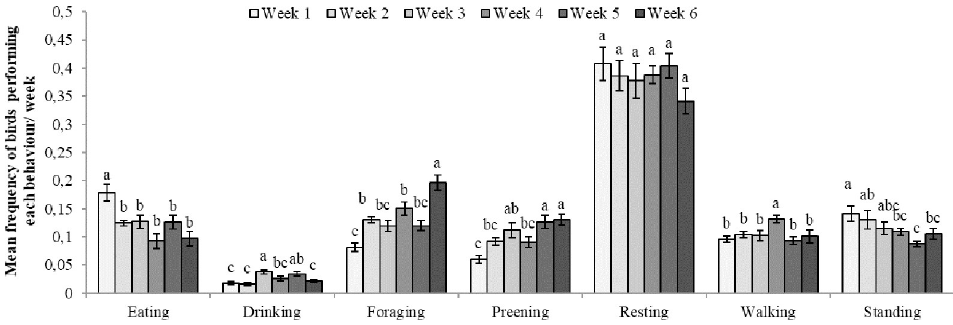
Fig 9. Mean ( ± SE) frequency of birds performing each behaviour by week. (a-c) letters indicate significant differences across weeks for eating, drinking, foraging, preening, resting, walking and standing.